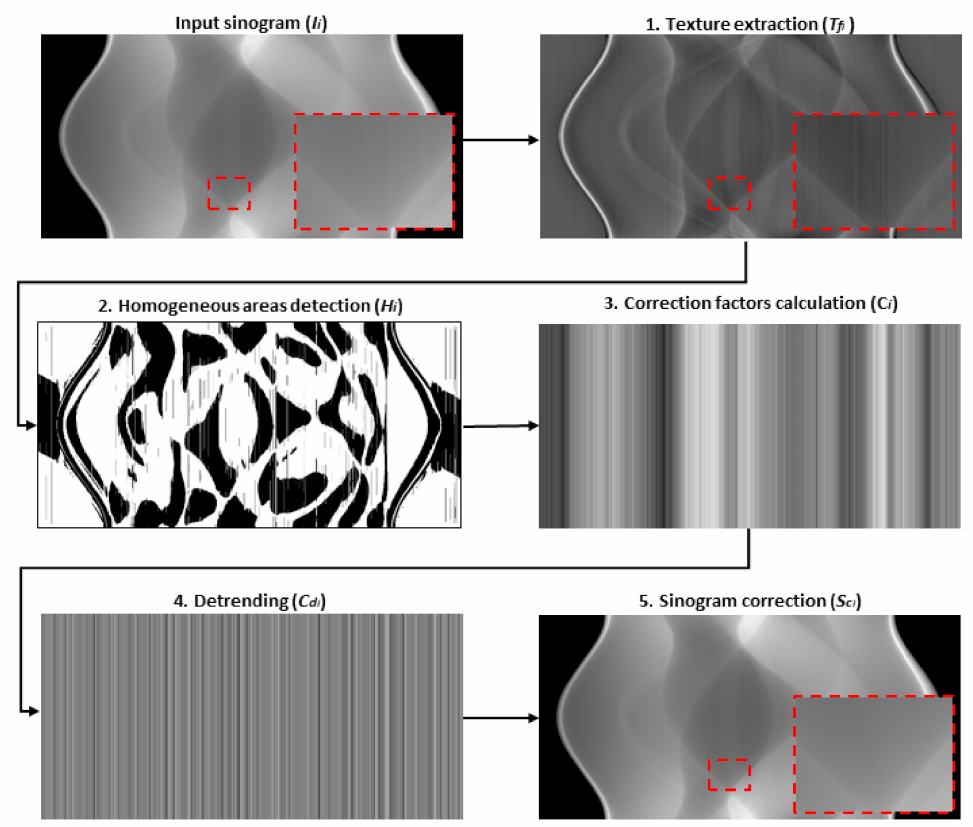
Figure 3. Illustrative scheme of the proposed low-level ring artifacts removal procedure—the outputs from the first iteration are shown as